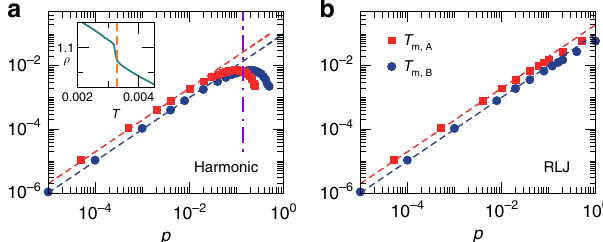
Fig. 2 Pressure dependence of the melting temperatures. a , b are for harmonic and RLJ systems, respectively. Squares and circles are for T m,A ( p ) and T m,B ( p ), respectively, with γ = 1.4 and Δ = 0. The dashed lines show the linear behavior. The vertical dot-dashed line in a shows the crossover pressure at which T m,A ( p ) and T m,B ( p ) intersect. By comparing with Fig. 1a, it is roughly p n at which χ A = χ B . The inset of a shows how the equilibrium melting temperature T m ( p ) is determined from simulation, which is also T p ) with Δ = 0 by de fi nition. At a fi xed pressure p , the melting m,B ( temperature T m (marked as the vertical dashed line) is the temperature at which the density ρ undergoes an abrupt change with the decrease of